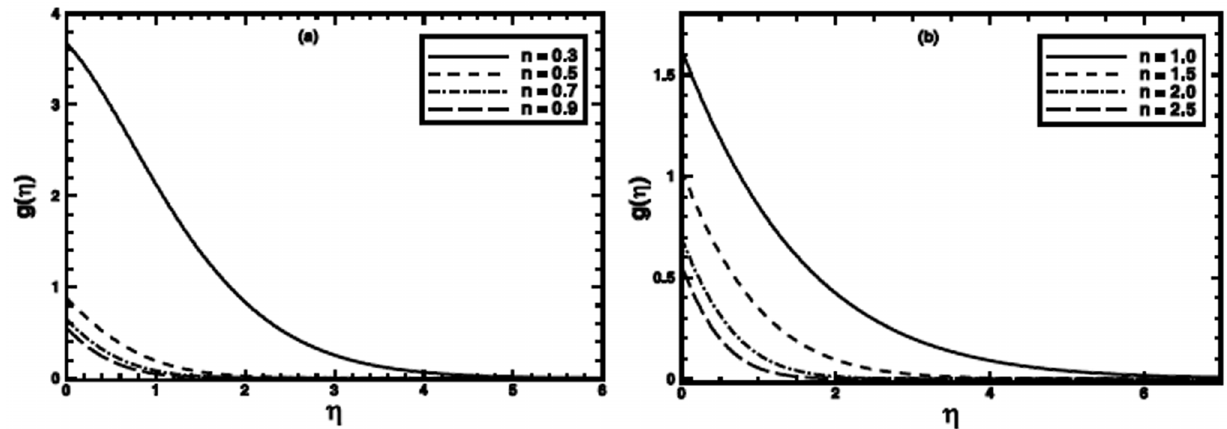
Figure 2. The temperature profile g g ð Þ in the PHF case for different values of the power-law index n when s ~ 1 : 5 , Pr ~ 3, m ~ 1 and A ~ 1 are fixed.